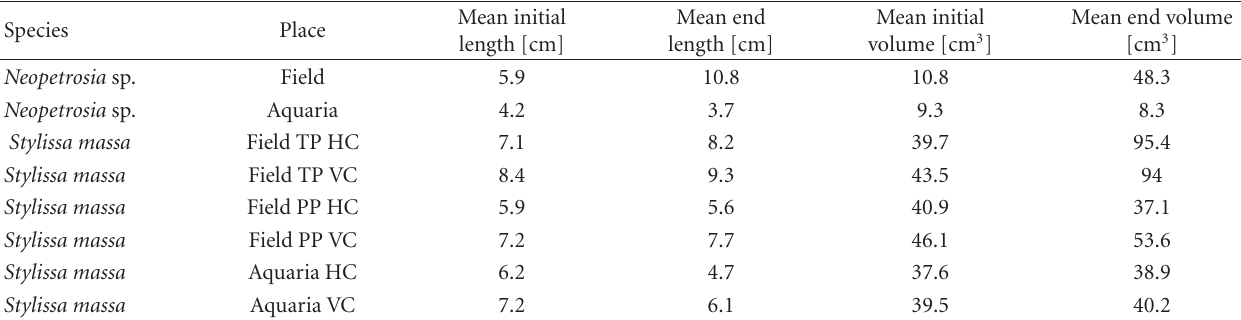
Table 2: Mean initial and end values of length and volume of fragments at the di ff erent sites for all methods. Mean initial Species Place length [cm] Neopetrosia